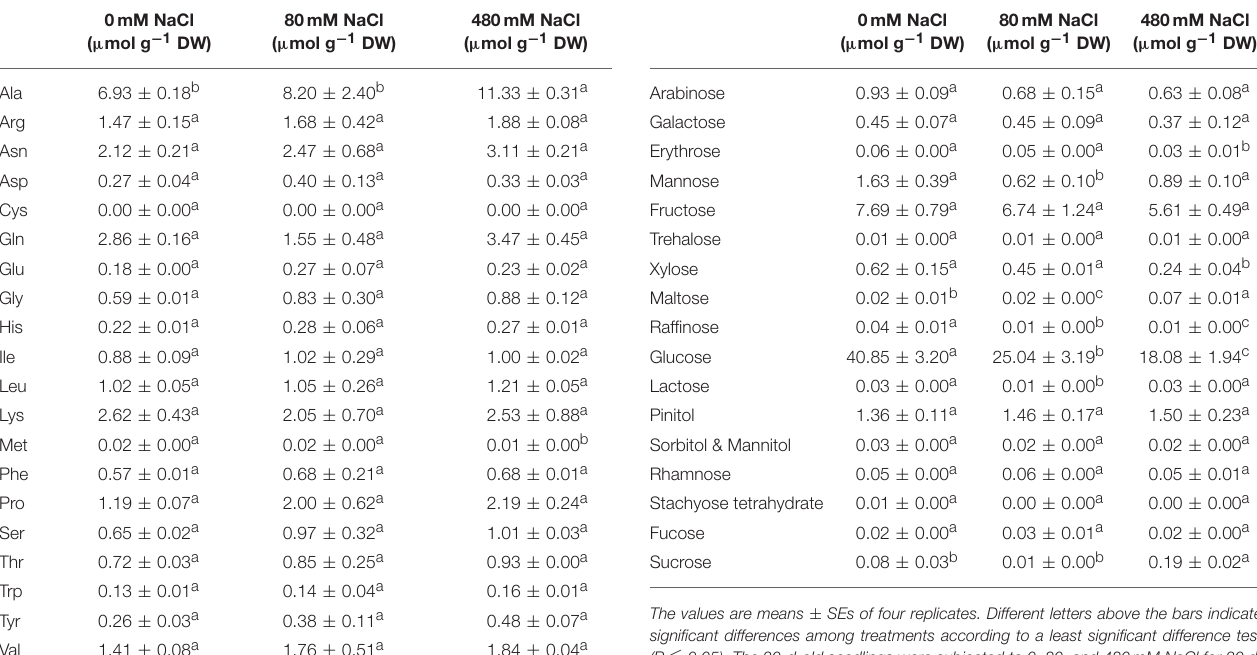
TABLE 6 | Effects of salt stress on the free carbohydrate contents in the leaves of K. sieversiana